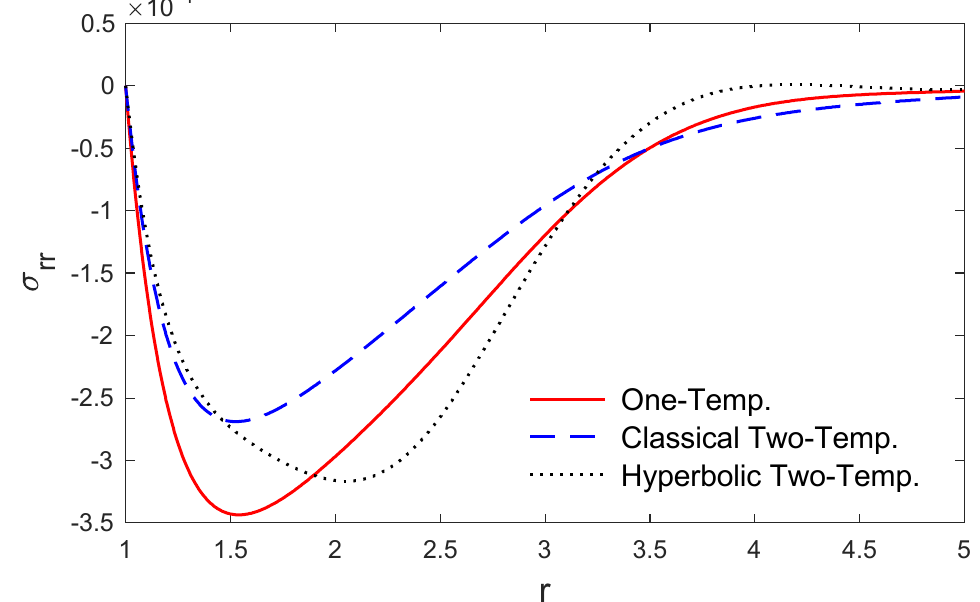
Figure 5. The variation of radial stress with distance for different models. Mathematics 2020 , 8 , x